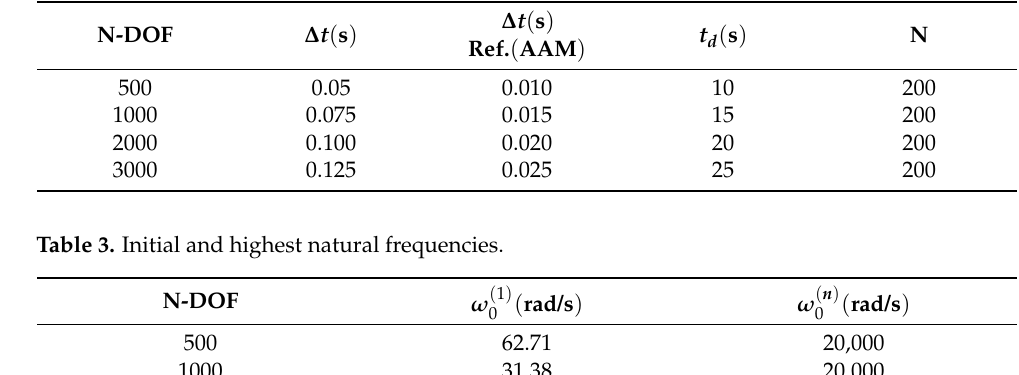
Figure 19. A new mass spring system. Table 2. Time integration data. Table 1. Ground acceleration.